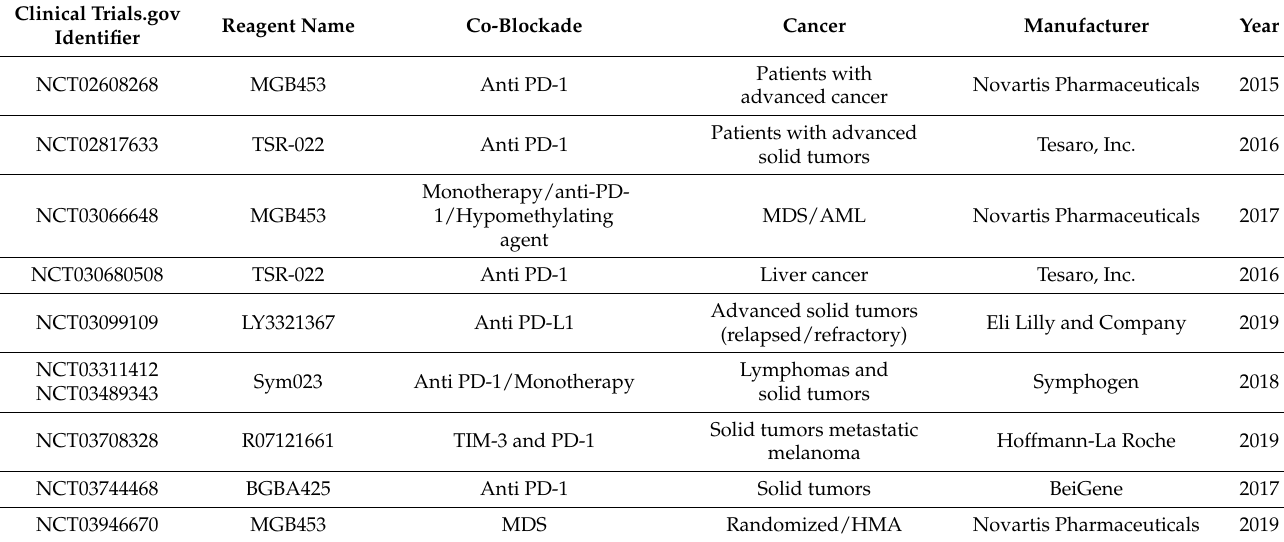
Table 1. Clinical trials initiated with Tim-3